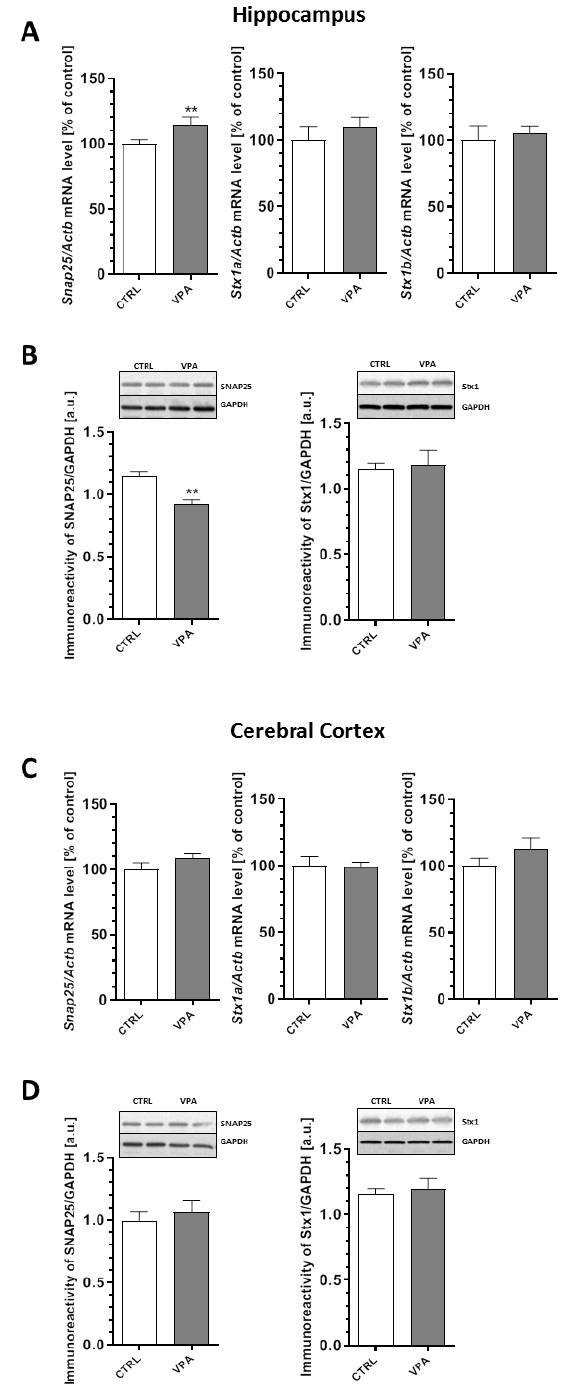
Figure 4. The e ff ect of prenatal exposure to VPA on the expression of the t -SNARE proteins: SNAP25 and Stx1. The gene expression of Snap25, Stx1a, and Stx1b in the hippocampus ( A ) and cerebral cortex ( C ) of the control and VPA-exposed rats was measured via quantitative RT-PCR and calculated by the ∆∆ Ct method with Actb ( β -actin) as a reference gene. Data represent the mean values ± SEM from n = (4–6) independent experiments in both the hippocampus and cerebral cortex. The immunoreactivity of the t -SNARE proteins in the control and the VPA-exposed rats was monitored using a Western blot analysis. Representative pictures and a densitometric analysis of SNAP25 and syntaxin 1 (Stx1) in the hippocampus ( B ) and cerebral cortex ( D ) are presented. The results were normalized to GAPDH levels. The data represent the mean values ± SEM from n = 5 independent experiments in both the hippocampus and cerebral cortex. ** p < 0.01, vs.